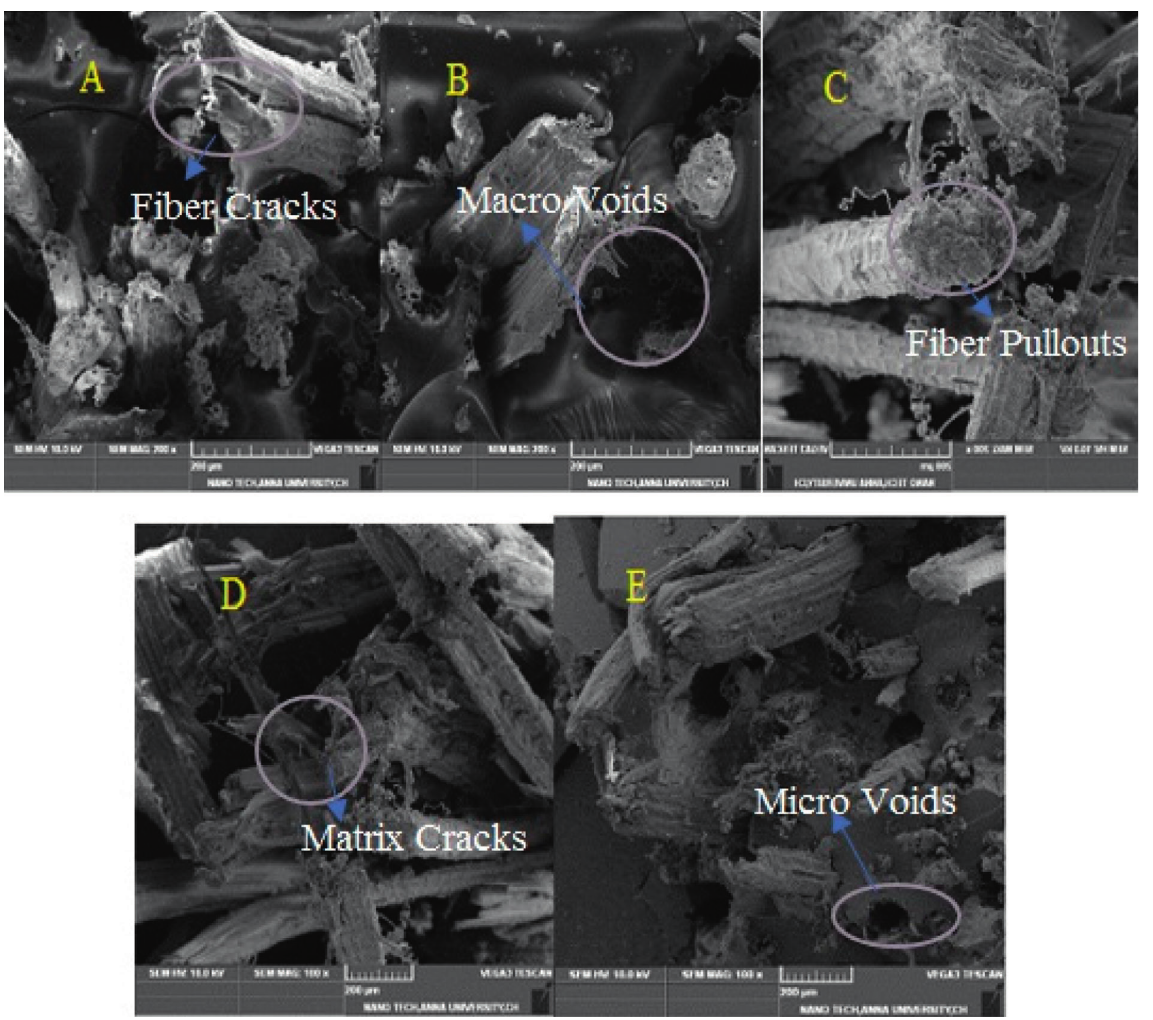
Figure 7: SEM micrographs of treated fiber composite